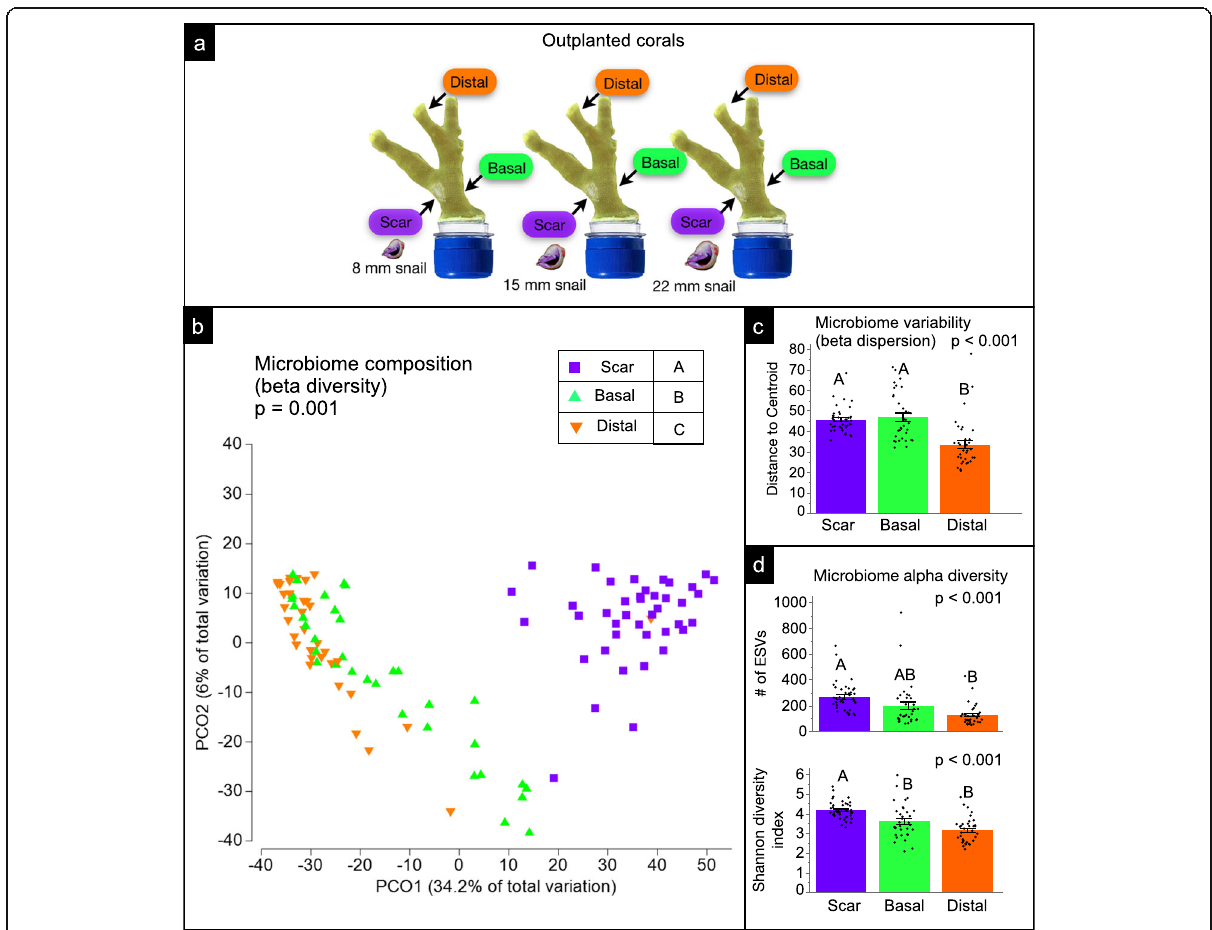
Fig. 3 Microbiomes of scar, basal, & distal locations on outplanted corals with snails. a Sampling schematic of locations from corals in our manipulative experiment that were subjected to snail feeding used for analyses (one-factor test, factor: location). b Microbiome composition (beta diversity) of samples by location. Letters in legend denote significant differences ( p < 0.01). c Microbiome variability (beta dispersion) of samples by location. Letters in legend denote significant differences ( p < 0.01). d Microbiome alpha diversity of samples by location. Letters in legend denote significant differences ( p < 0.01). Analyses were performed following rarefaction (subsampling without replacement) to a uniform sequence count of 8013 sequences per